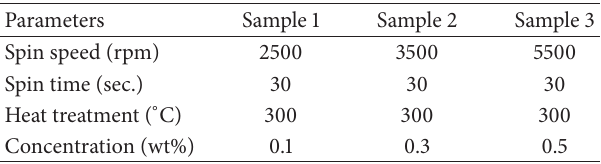
Table 1: The spin coating parameters of NDPs films for each factor and level as defined by the Taguchi experiment